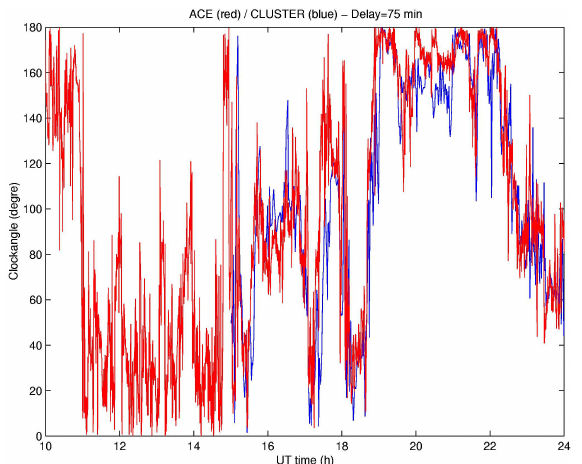
Fig. 3a. Overview of the IMF clock angle seen by Cluster FGM in the magnetosheath after 15:00 UT (blue) in comparison with the IMF clock angle seen by the ACE satellite at 220 R E upstream from 10:00 to 24:00 UT on 14 January 2001 (red).